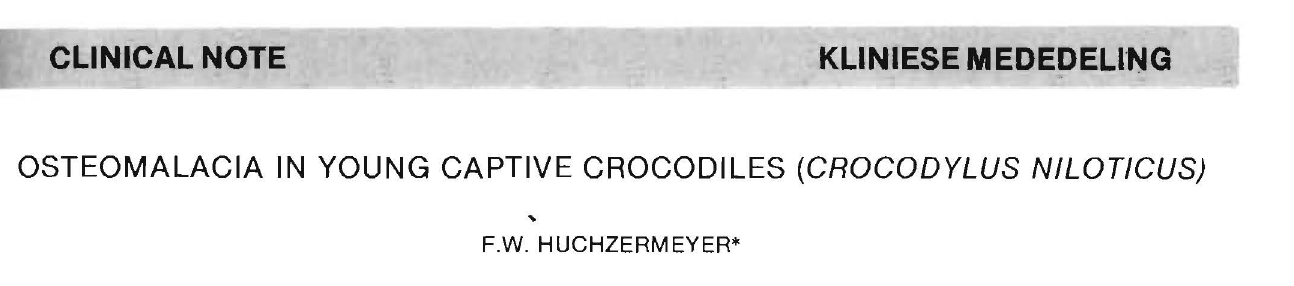
Fig. 1: Kyphoscoliosis caused by osteomalacia in a young crocodile.